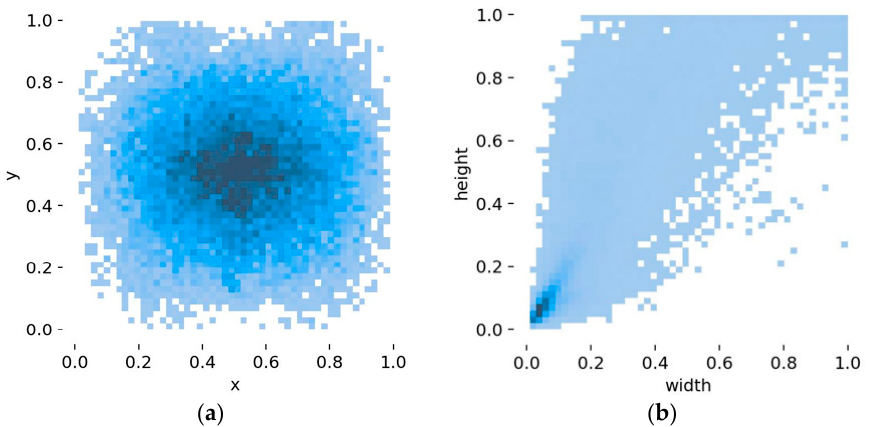
Figure 7. Visualization of the dataset. ( a ) The location of object boxes; ( b ) The size of object boxes.